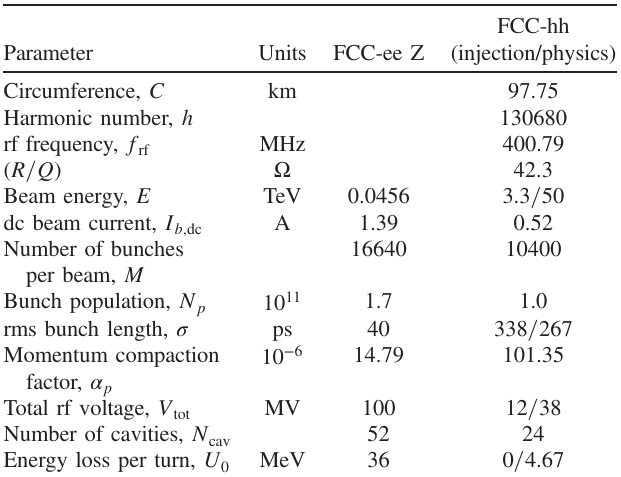
TABLE I. The parameters of high-intensity high-luminosity colliders used for calculations in this work